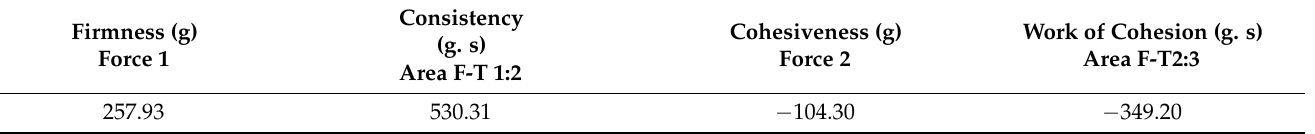
of cohesion of ethosomal